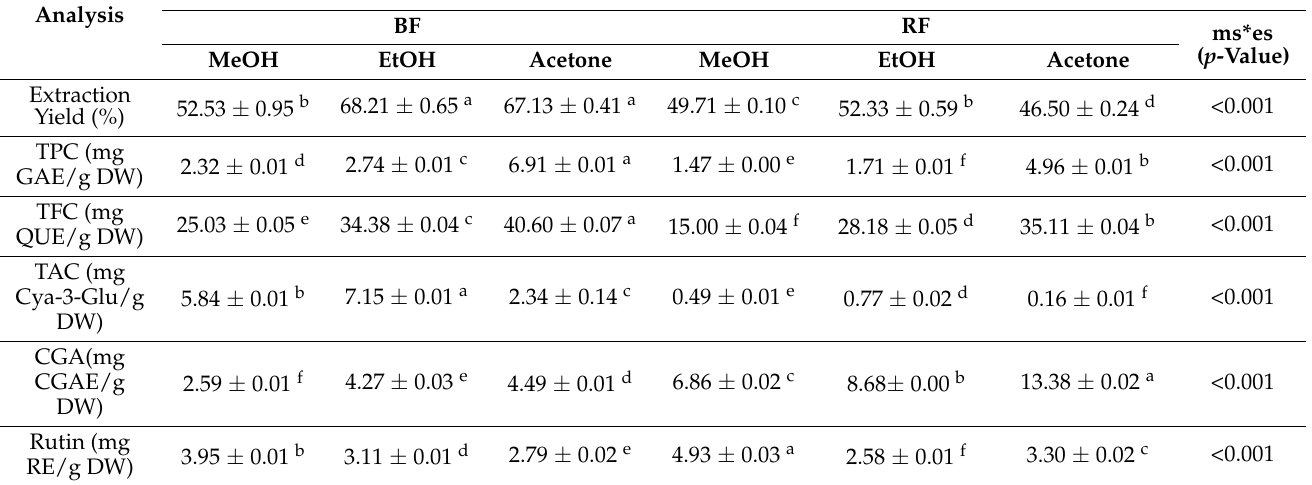
Table 1. The values of extraction yield, total bioactive content, chlorogenic acid, and rutin of mulberry fruits. The result of two-way ANOVA are shown for the interaction of the two factors: maturation stages (ms) and extraction solvent